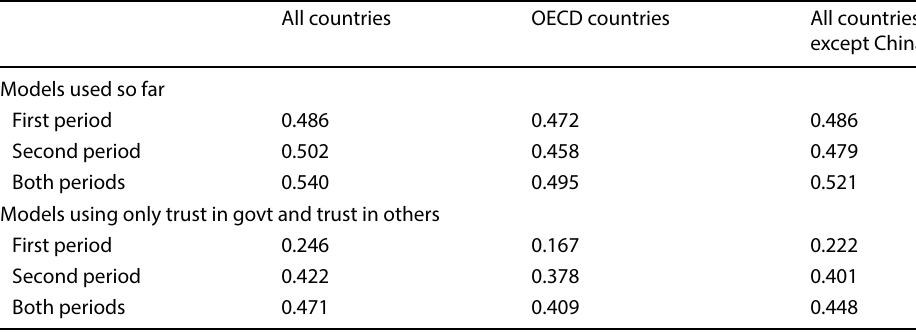
Table 5 R 2 values